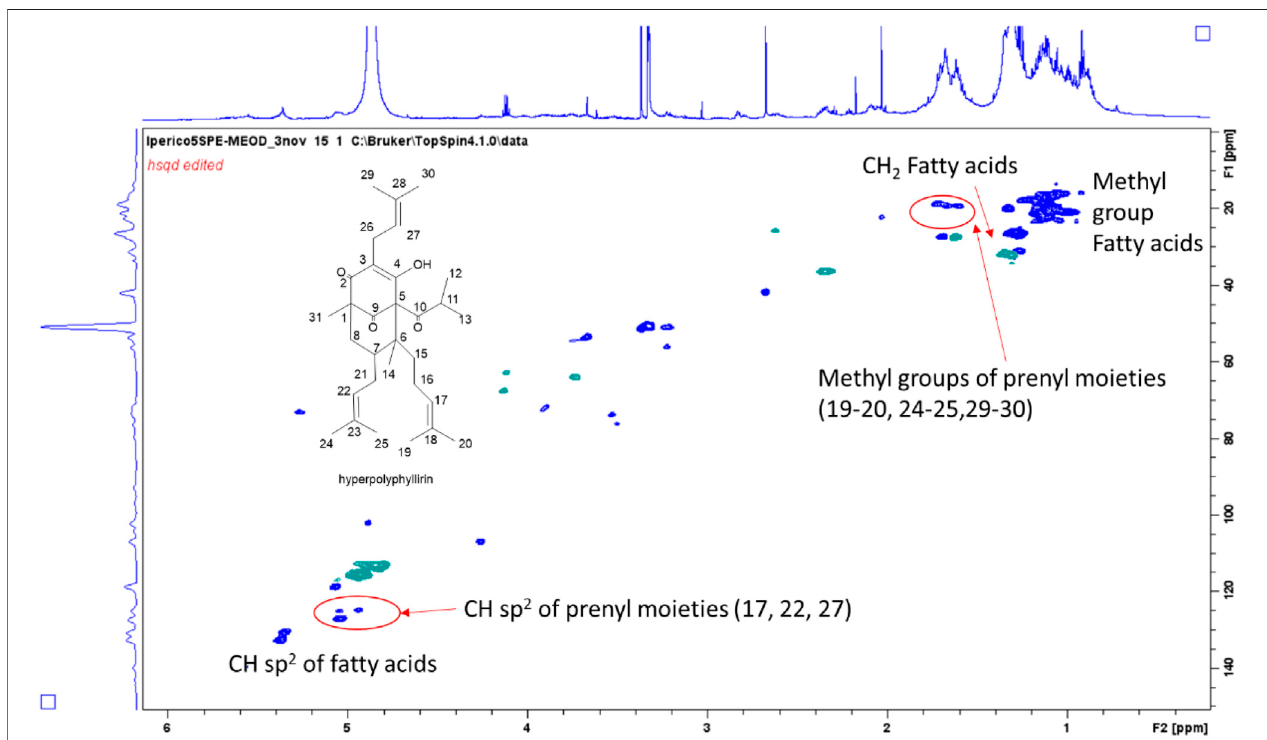
FIGURE 3 | HSQC-DEPT-NMR spectrum of the methanol ATM fraction of H. triquetifolium aerial parts obtained by SPE. The structure of hyperpolyphyllirin and some of the assigned positions are highlighted.